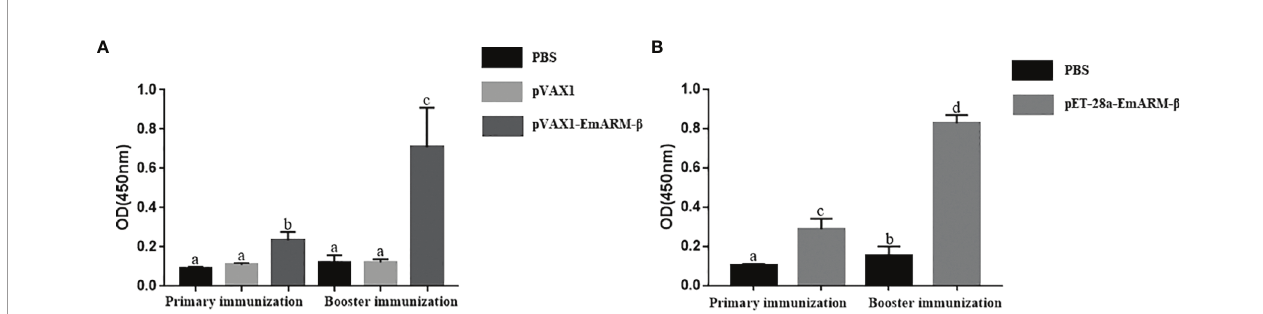
FIGURE 9 | Speci fi c IgG titers in chicken serum induced by EmARM- b . (A) Serum IgG titers induced by recombinant plasmid pVAX1-EmARM- b . (B) Serum IgG titers induced by recombinant protein pET-32a-EmARM- b . The small letters (a-c) indicate difference between groups in the same panel. The same letter indicates no signi fi cant difference between different groups (p > 0.05). The different letter indicates signi fi cant difference between different groups (p <